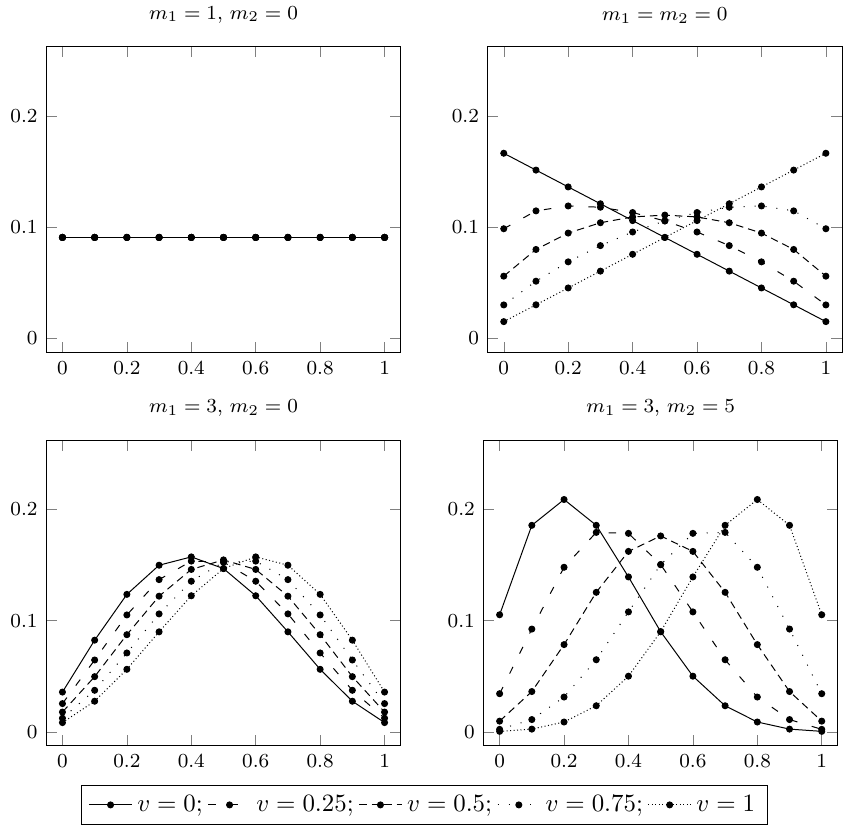
Figure 4: Beta-Binomial distribution. The distribution of the Beta-Binomial random variables with n = 10 is displayed for different parameters choices. The Beta- Binomial loss distribution for a single entity: m 1 = 1 and m 2 = 0 (top left), m 1 = 1 and m 2 = 1 (top right), m 1 = 3 and m 2 = 1 (bottomleft), m 1 = 3and m 2 = 5(bottomright).Ineachpanel,thedistributionisrepresentedfordifferentvaluesofthesystematic